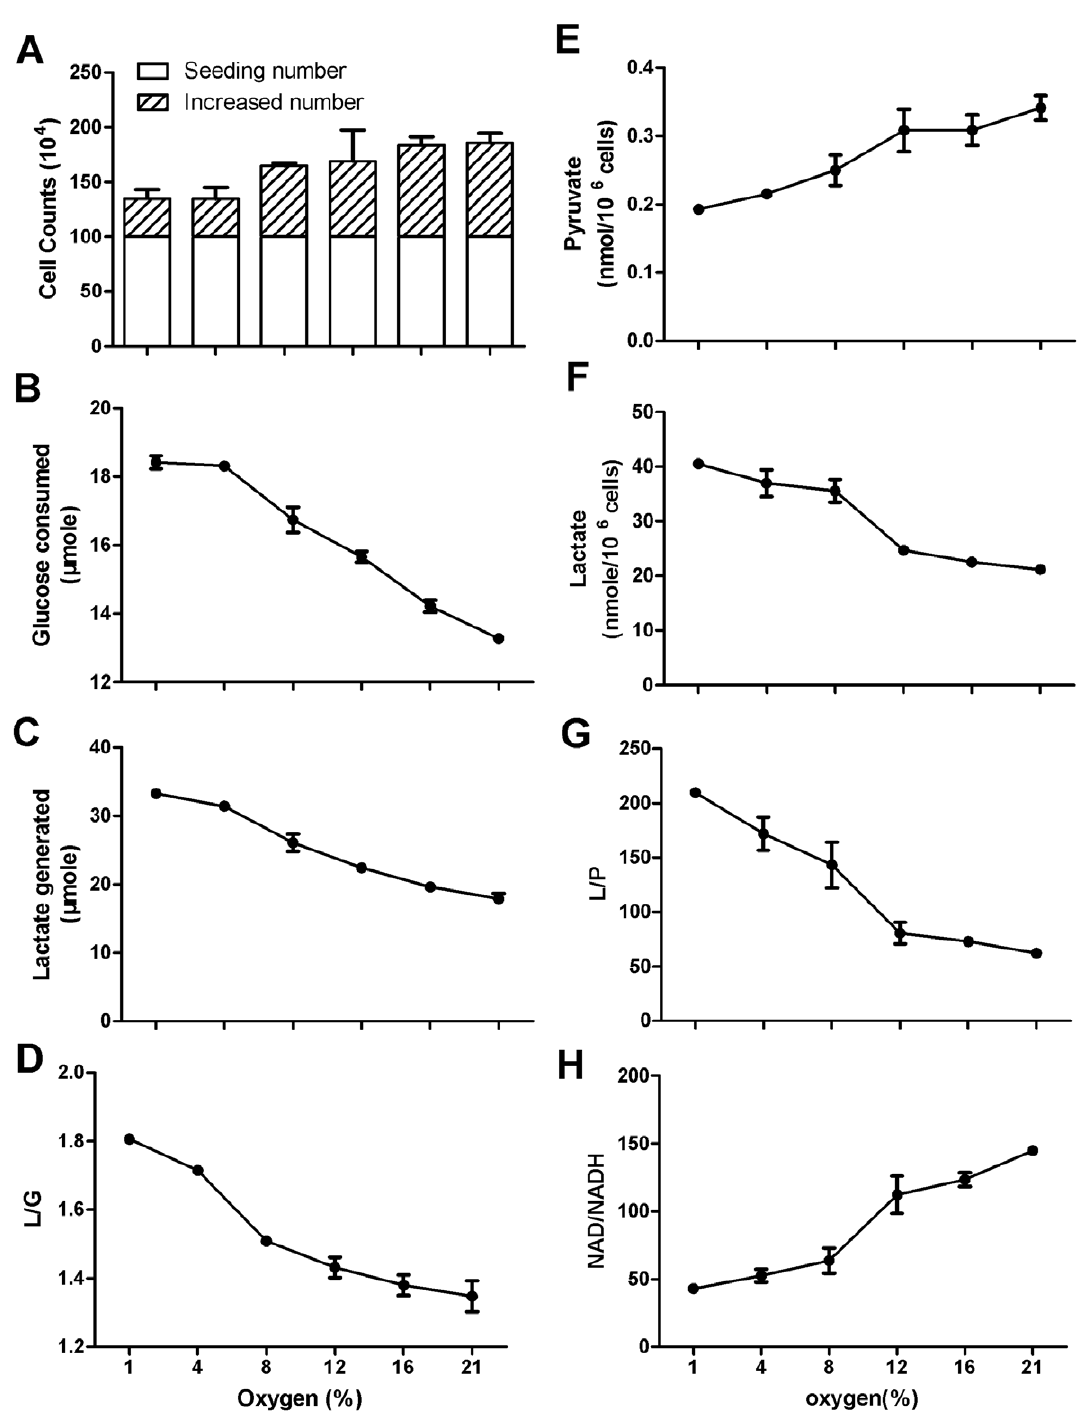
Figure 4. The effect of oxygen levels on intracellular concentration of lactate and pyruvate in Hela cells. Hela cells were incubated in complete RPMI-1640 medium containing 12 mM glucose. After 24-hour incubation, glucose consumption and lactate generation by Hela cells, cell growth, and intracellular lactate and pyruvate were measured. (A) Cell proliferation; (B) Glucose consumption; (C) Lactate generation; (D) L/G ratio; (E) Intracellular pyruvate; (F) Intracellular lactate; (G) Intracellular L/P ratio; (H) Cytosolic free NAD/NADH ratio erroneously estimated from the corresponding L/P ratio. Data are mean 6 SD. Data were confirmed by 2 independent experiments.